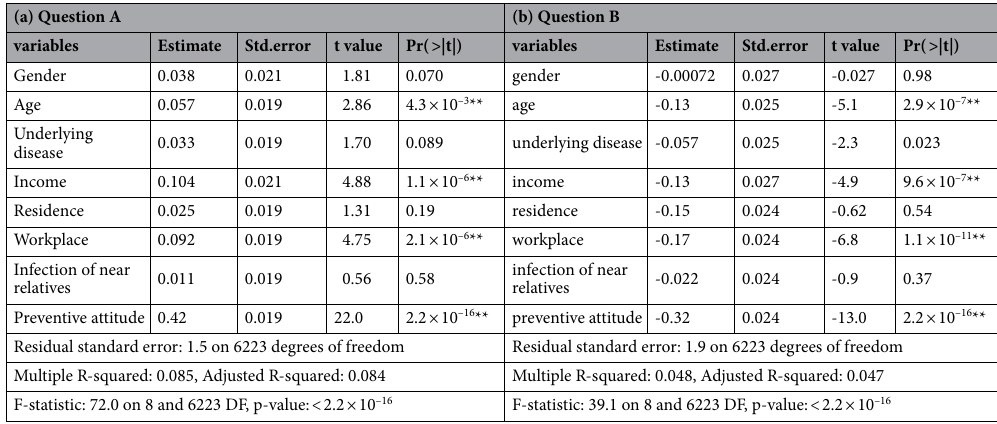
Table 2. Multiple linear regression of the willingness and refusal to be vaccinated with participants’ demographic characteristics. Codes for significance: 0 ‘**’, 0.01 ‘*’, 0.05 ‘.’ 0.1.